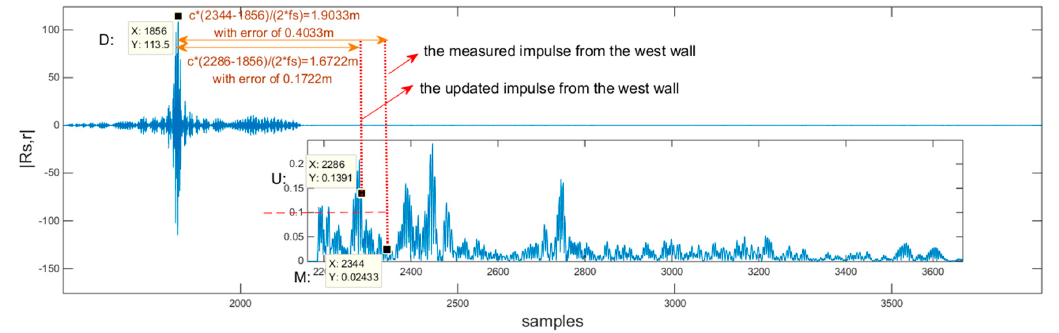
Figure 8. R ( τ ) when κ = 140, k = 1. The R ( τ ) wave is generated when the step index of the s , r s , r Figure 8. 𝑅(𝜏) (cid:3046),(cid:3045) when 𝜅 = 140,𝑘 = 1 . The 𝑅(𝜏) (cid:3046),(cid:3045) wave is generated when the step index of the pedestrian is κ = 140, the impulses marked in red dot lines are the reflections from the west pedestrian is 𝜅 = 140 , the impulses marked in red dot lines are the reflections from the west wall.